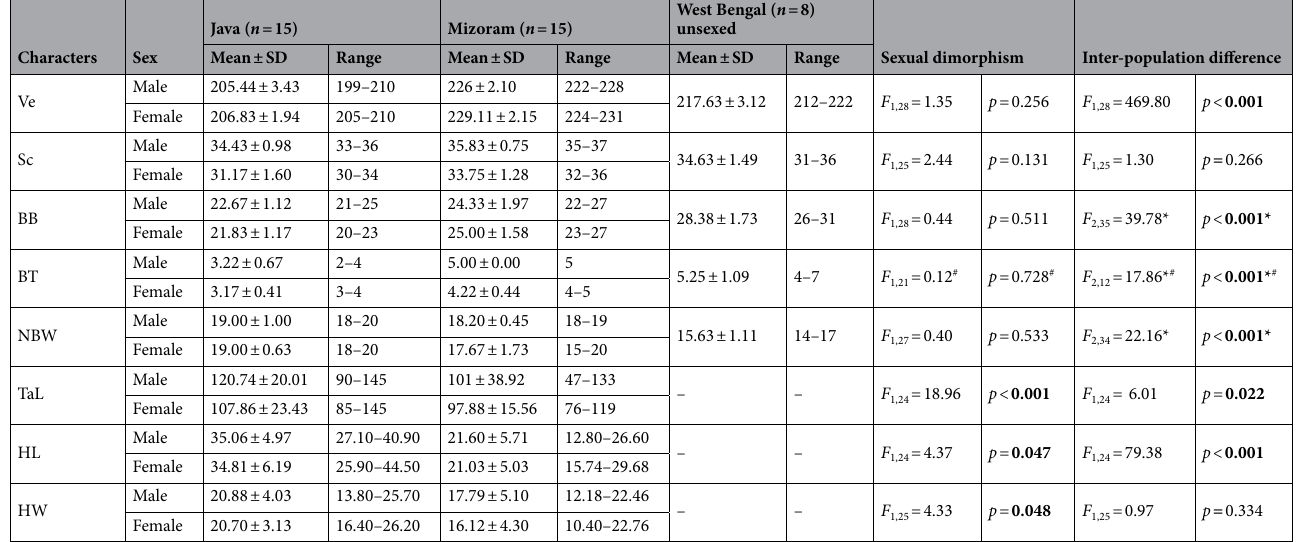
Table 1. Evaluation on the meristic and mensural characters measured for 38 Bungarus fasciatus individuals from Java (JV), Mizoram (MZ), and West Bengal (WB), including mean, standard deviation, minimum and maximum values. Standardized meristic data were utilised for the following tests: Ve of JV and MZ was tested for inter-population difference and sexual dimorphism using separate one-way ANOVA with locality and sex as the factors, respectively; Sc of JV and MZ was tested using two-way ANCOVA using sex and locality as factors; BB and NBW were tested for inter-population difference (among the three populations) and sexual dimorphism (within JV and MZ) using separate one-way ANOVA with locality and sex as the factors, respectively; since BT violated the assumption of homoscedascity, it was tested using the alternative Brown- Forsythe test and was indicated by octothorp (#). For mensurals, two-way ANCOVA was performed for the log transformed TaL, HL, and HW values from JV and MZ by using the log transformed SVL as a covariate, with locality and sex as the factors. The characters with statistically significant variations at the alpha level of 0.05 are shown in boldface. The characters tested for inter-population difference across the three populations are indicated by asterisk (*). Significant values are in